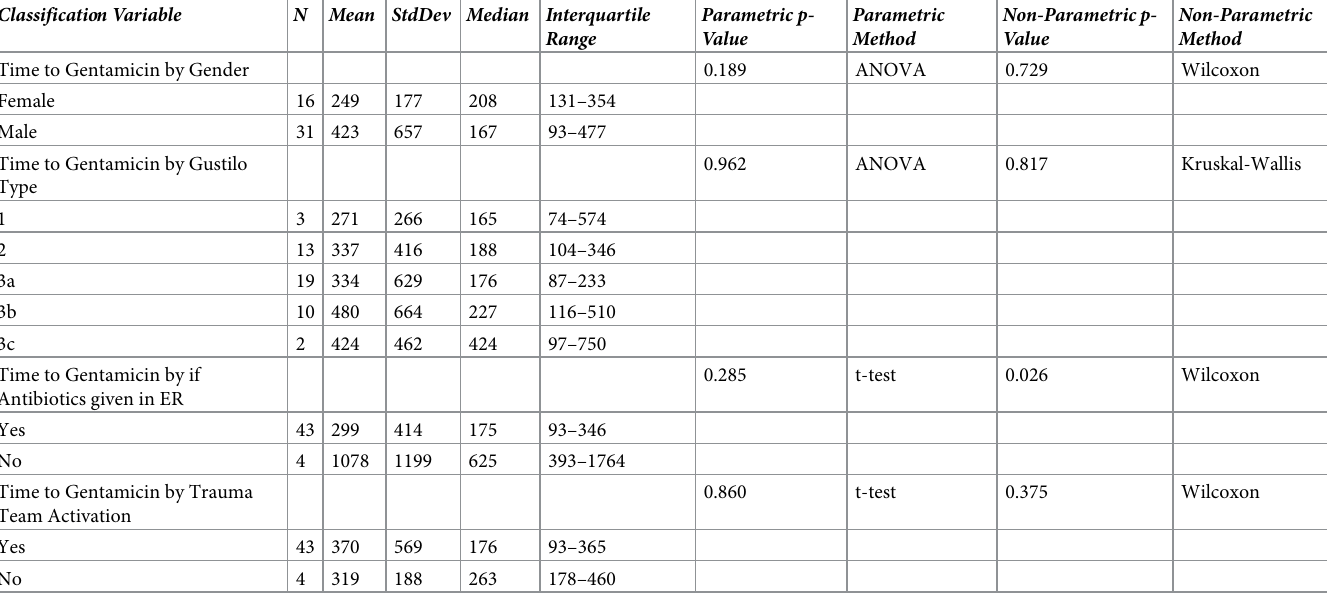
Table 3. Summary of timing to gentamicin